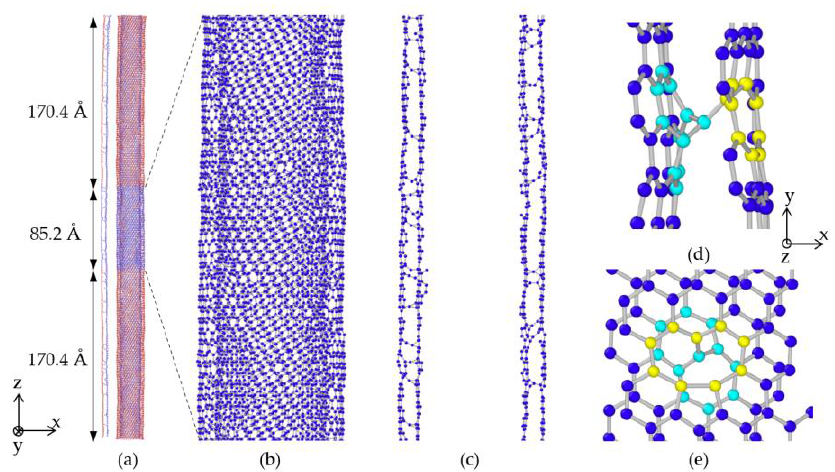
Figure 1. Schematic diagram of the computational model. ( a ) Entire 2WCNT with Frenkel-pair crosslinks and distortions on the wall with a half front slice on the left side, where the two red parts (on the outermost wall) indicate the regions of load application during the tensile test and are named fixed parts. The blue color (including all inner walls) represents the parts where atoms can move freely, and are thus named mobile parts; ( b ) Magnified view of the middle mobile part of 2WCNT; ( c ) Front slice of ( b ) showing randomly distributed crosslinks; ( d , e ) Structure of Frenkel-pair crosslink. Light blue balls represent carbon atoms on the inner walls, and yellow balls are atoms on the outer walls.